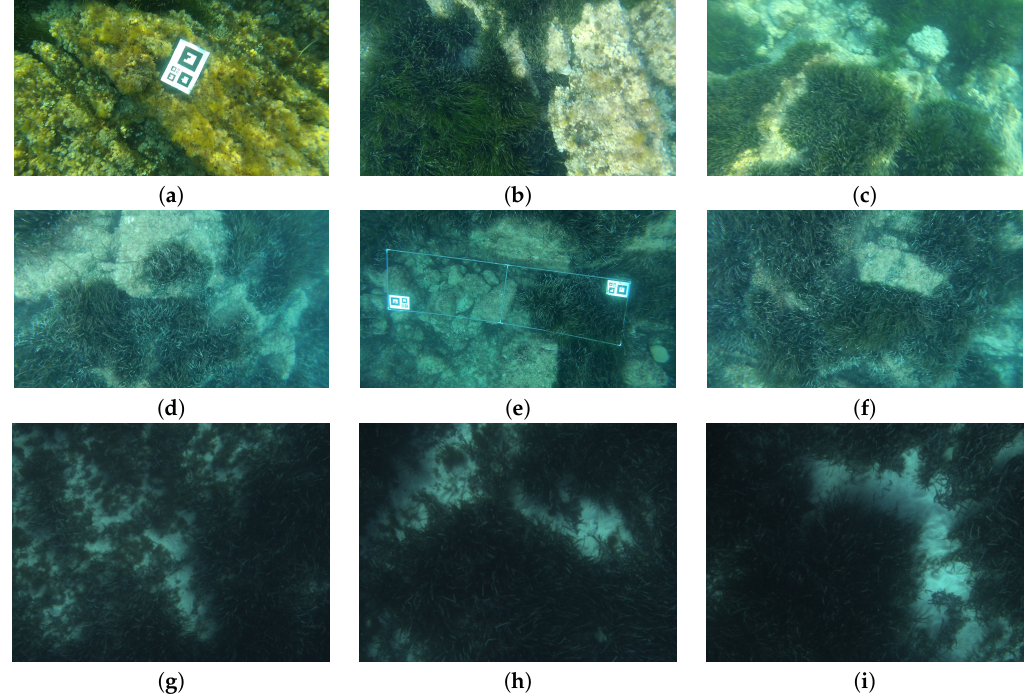
Figure 4. Examples of images of dataset 1, in ( a – c ), dataset 2, in ( d – f ), and dataset 3, in ( g – i